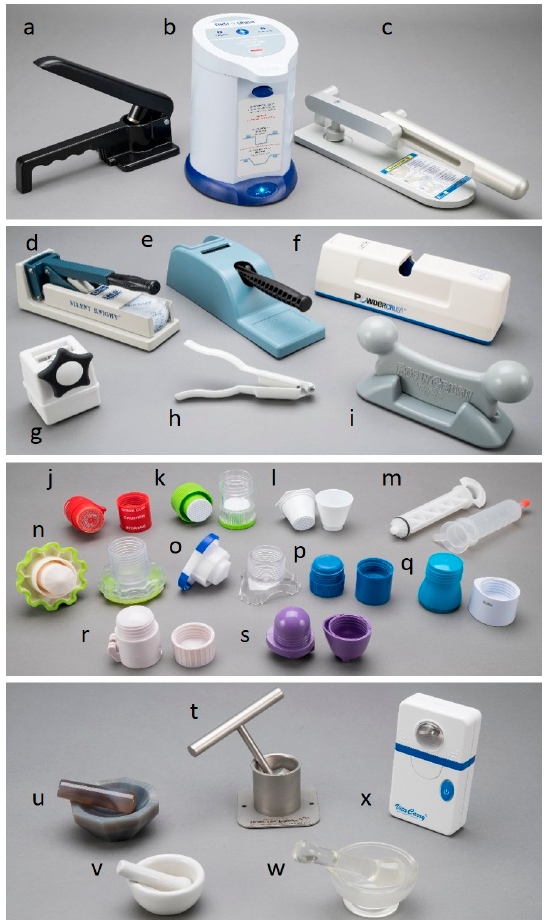
Figure 3. Various options available to split and crush tablets. Images ( a ) through ( c ) are representations of tablet crushers. Images ( d ) through ( i ) are various tablets splitters that can be used for different shape tablets that are embossed with a score line. Images ( j ) though ( s ) are tablet grinders; these are designed to grind and crush tablets to deliver finely crushed powder medication. Images ( t ) through ( w ) are tablet pulverizers that are designed to crush tablets to a fine powdered medication. They are available as ball and sockets and as motor and pestle. Image reproduced from the article [129]. Permission to include this image in this review has been obtained from PLOS